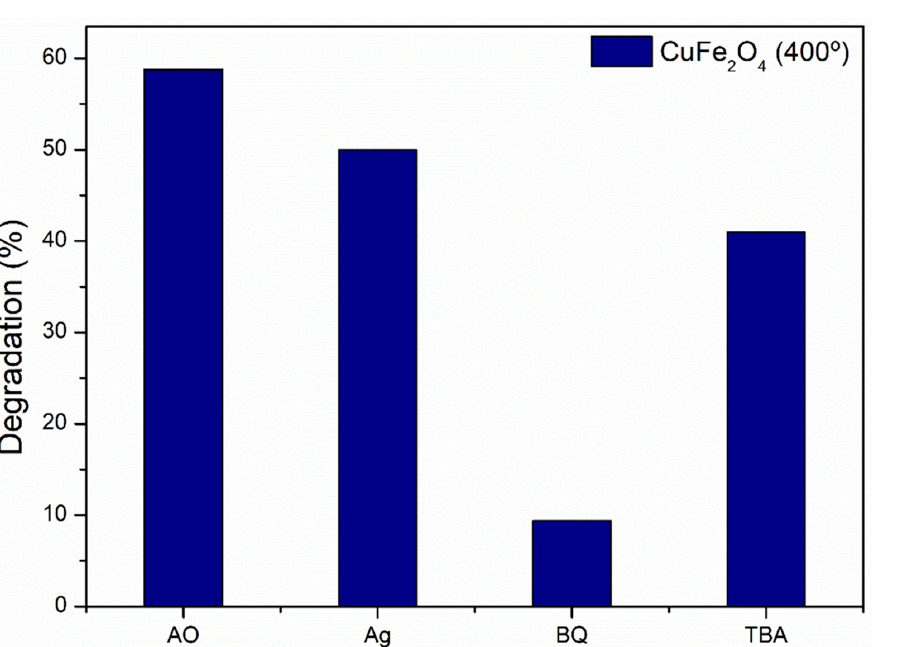
Figure 13. The mechanism of the reaction with the CuFe 2 O 4 sample at 400 °C under visible irradiation being Ag—silver nitrate, AO—ammonium oxalate, BQ—benzoquinone, and TBA—tert-butyl alcohol.